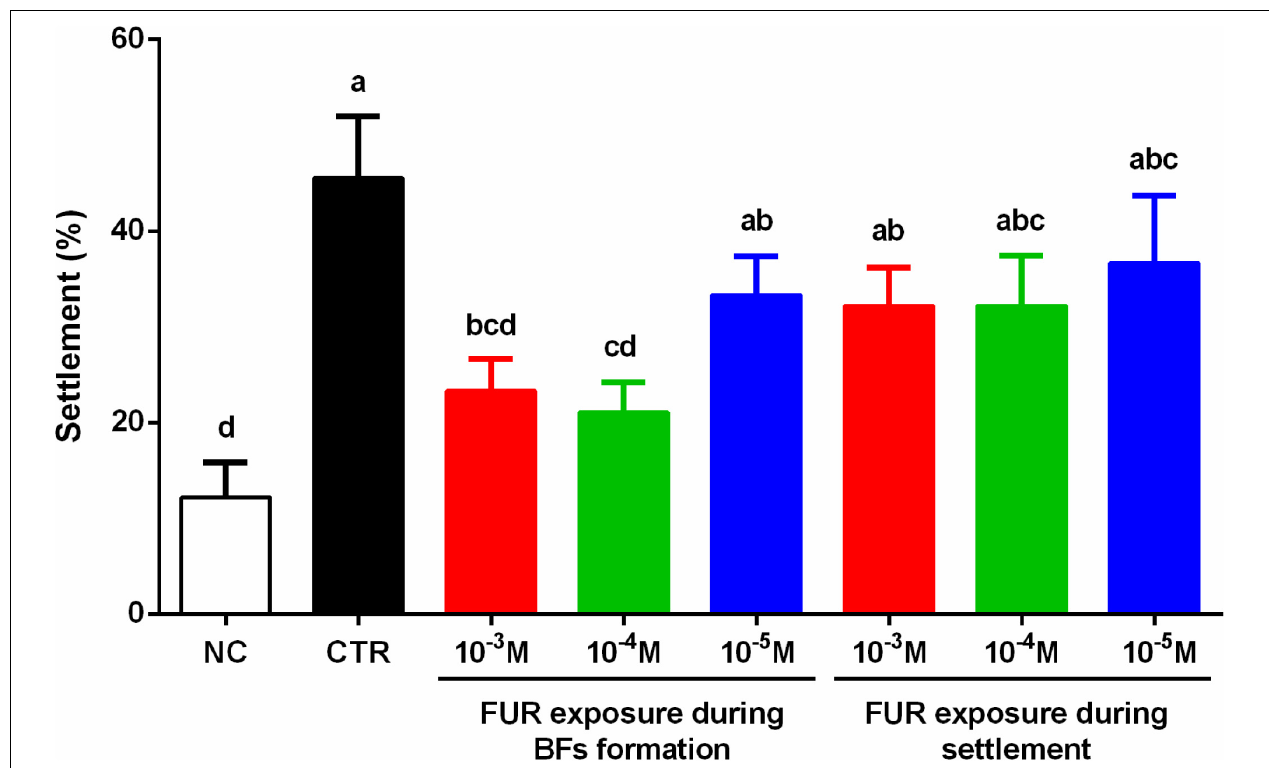
FIGURE 1 | Percentages of the settlement of M. coruscus plantigrades. Significant differences ( p < 0.05) are represented by different letters above the columns. Control (CTR), P. marina ECSMB14103 biofilm prepared on a sterile glass slide without adding FUR; negative control (NC), non-biofilm glass slide.